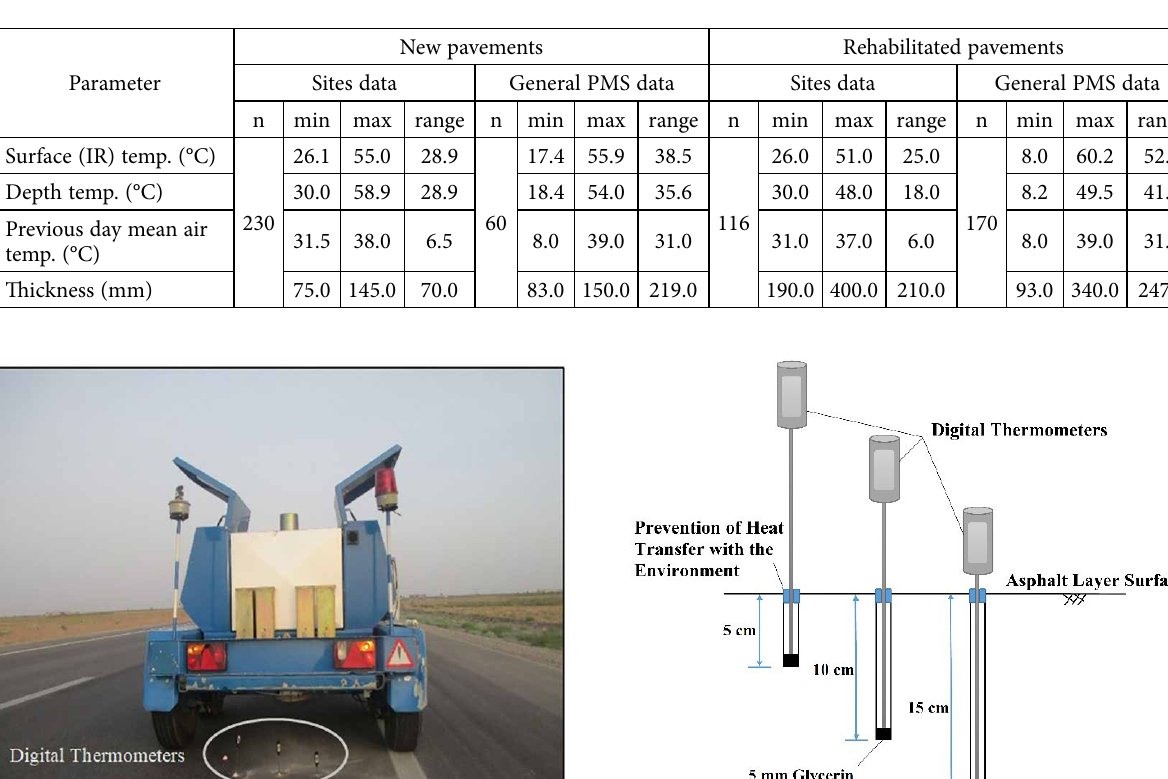
3. Data parameters taken from selected sites and general PMS database